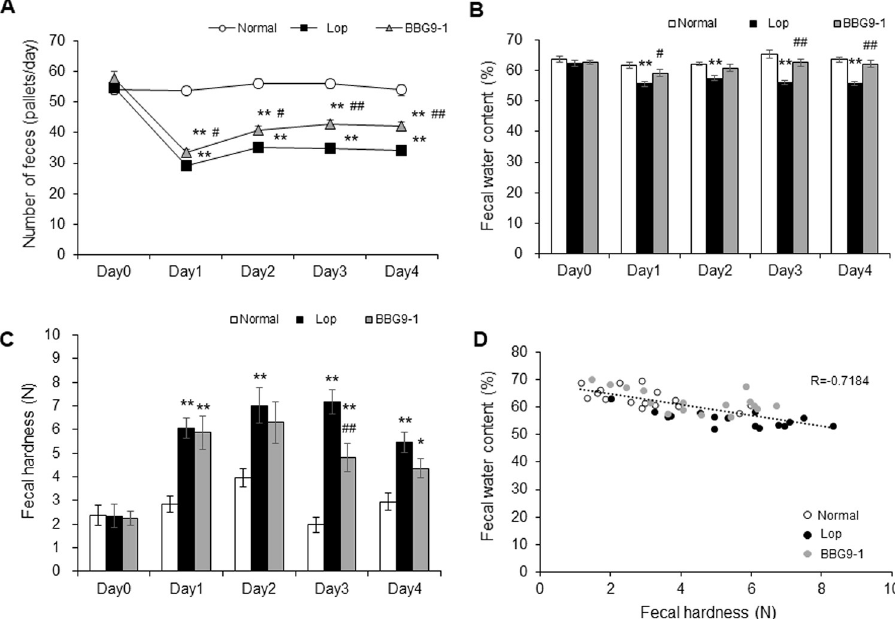
Fig 1. Change in fecal properties in rats with loperamide-induced constipation. (A) Number of feces, (B) Fecal water content, and (C) Fecal hardness were measured every experimental day. (D) Correlation between fecal water content and hardness was assessed at day 4. Values are means ± standard error (SE) of 16 animals. � and �� , p < 0.05 and 0.01 vs. Normal; # and ##, p < 0.05 and 0.01 vs.